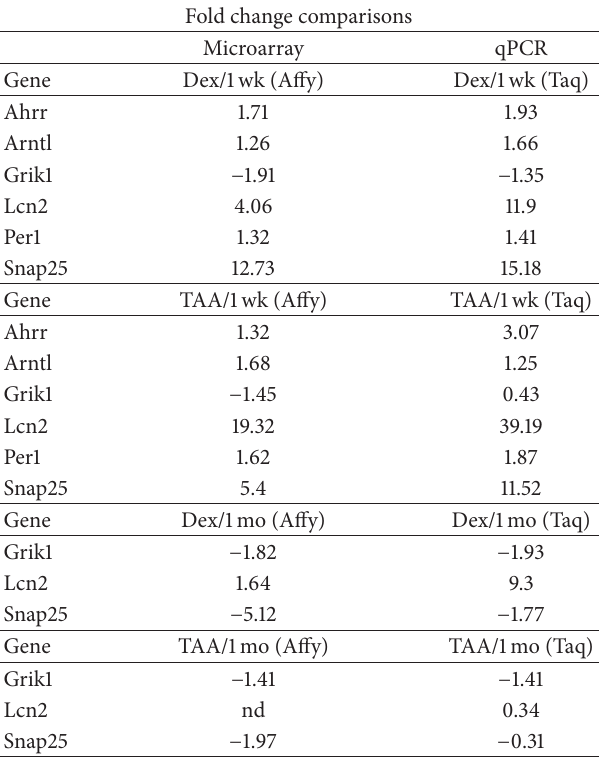
Table 2: Comparison of microarray and qPCR